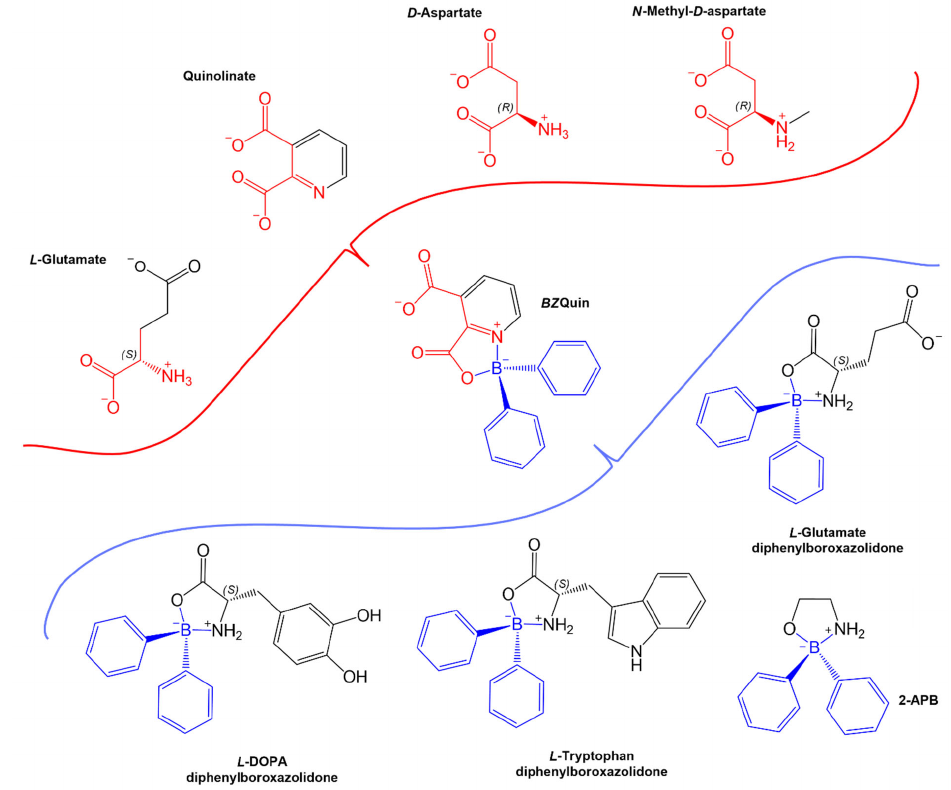
Figure 2. BZQuin structure comparison: (Red) EAA and quinolinate, which are iGluR and mGluR agonists; (Blue) diphenylboroxazolidones, which modify ionic channel activity or exert ameliorative effects on murine models of neurodegenerative diseases. The structural resemblances between BZQuin and both types of compounds are highlighted in their respective colors. The chemical structures are represented while considering protonation and deprotonation of their groups at physiological pH (7.4).